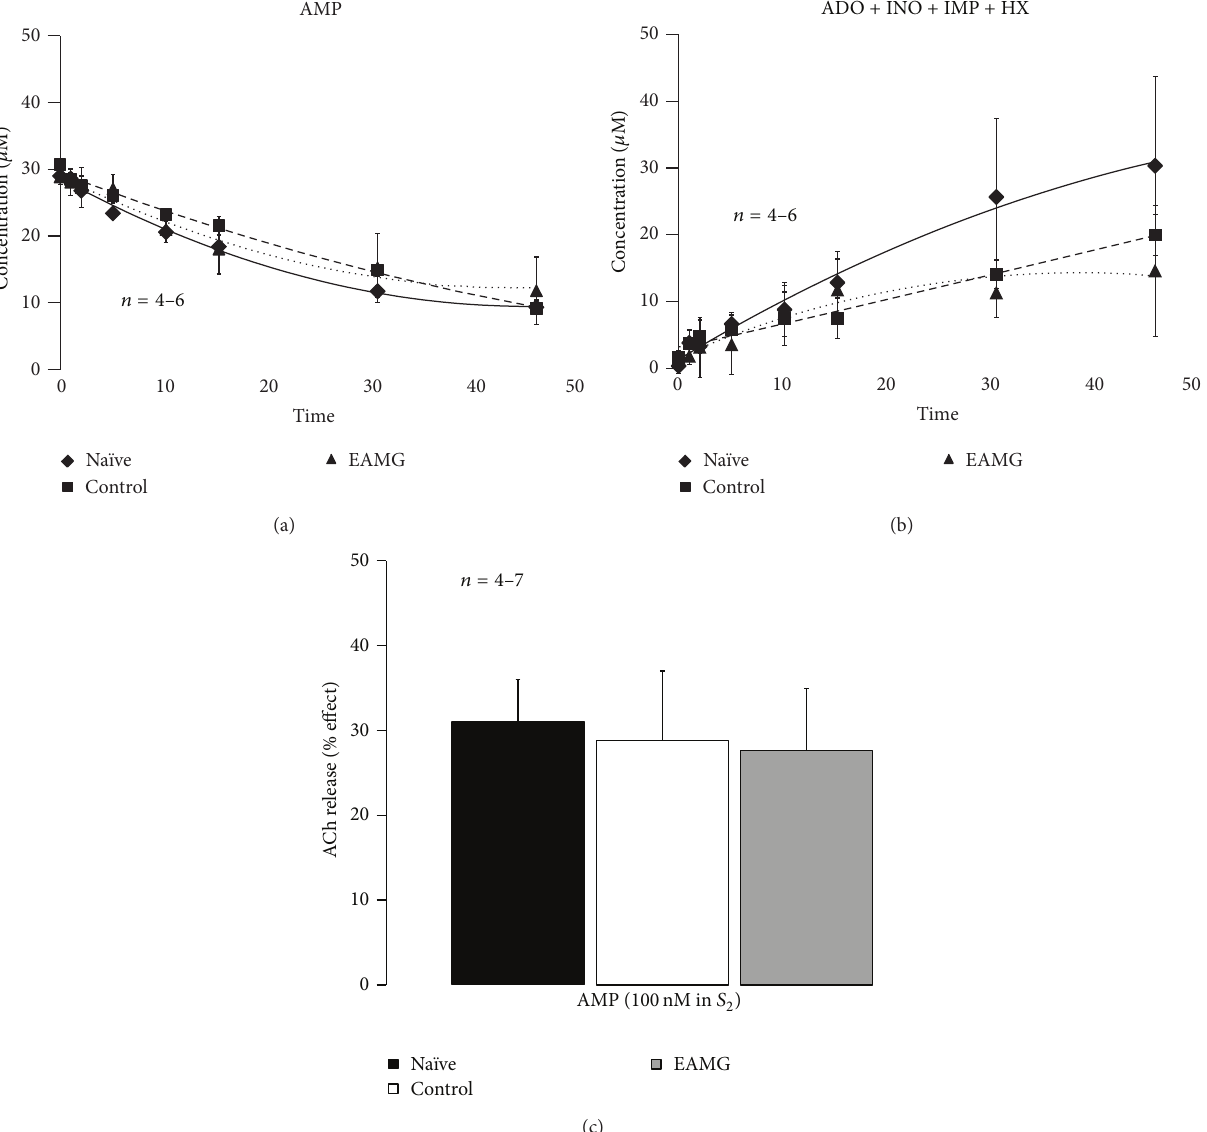
Figure 6: Dephosphorylation of AMP, to ADO via ecto-5 󸀠 -nucleotidase/CD73, facilitates the release of [ 3 H]-ACh from stimulated phrenic motor nerve terminals of na¨ıve, control, and EAMG rats. (a) and (b) show the kinetics of the extracellular AMP (30 𝜇 M) catabolism (a) and formation of ADO plus nucleoside derivatives (inosine (INO) and hypoxanthine (HX)) (b) in hemidiaphragm preparations from na¨ıve, control, and EAMG rats. AMP (30 𝜇 M) was added to the preparation at zero time; samples were collected from the bath at indicated times on the abscissa and retained for HPLC analysis. Data shown are averages pooled from 4 na¨ıve, 6 control, and 6 EAMG animals. The vertical bars represent SEM and are shown when they exceed the symbols in size. (c) Facilitatory effects of AMP (100 𝜇 M) on evoked [ 3 H]-ACh release (5Hz, 750 pulses, 𝑆 1 and 𝑆 2 ) from hemidiaphragm preparations from na¨ıve, control, and EAMG rats. AMP (100 𝜇 M) was applied 15min before 𝑆 2 . Each column represents pooled data from 4 (na¨ıve and control) and 7 (EAMG) animals. The vertical bars represent mean ±